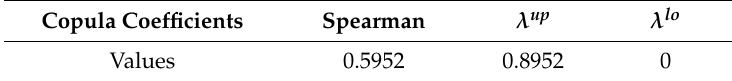
Table 5. Results of correlation coefficients of wind speeds between two wind farms. Copula Coefficients Spearman